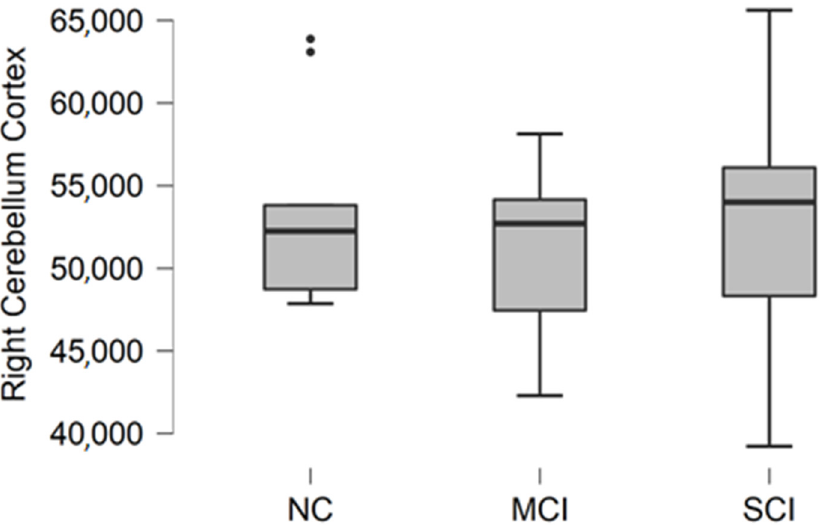
Figure 4. Mean right cerebellum cortex volume in mm 3 with standard deviation in participant groups. Black dots represent outliers (i.e., exceptionally diverging groups. Black dots represent outliers (i.e., exceptionally diverging values).